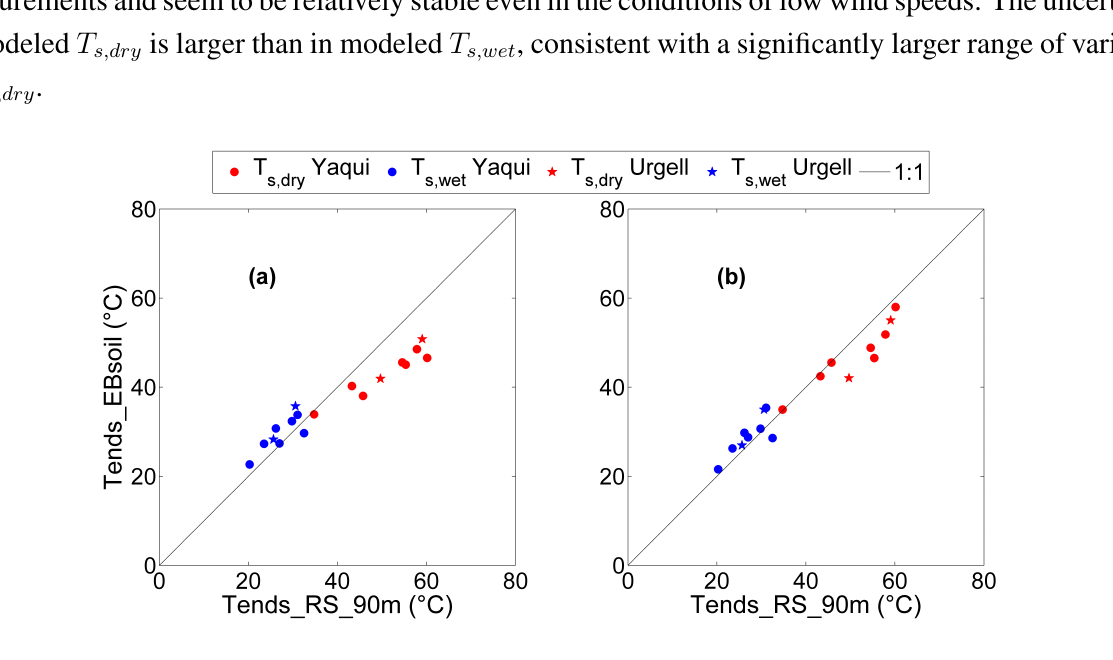
Figure 9. The soil Tends simulated by EBsoil for the ( a ) RI and ( b ) MO aerodynamic resistance are plotted against the image-based Tends for the Yaqui and Urgell regions